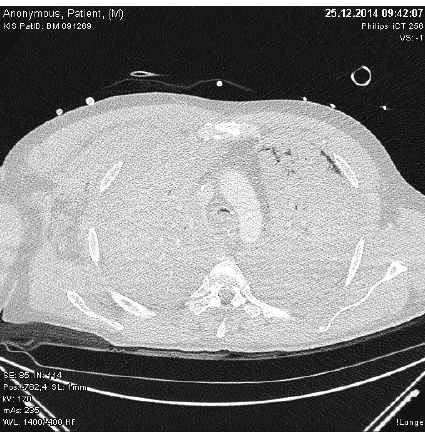
Figure 1: Lung computer tomography confirmed severe bilateral pulmonary consolidation with only minor residual ventilated lung